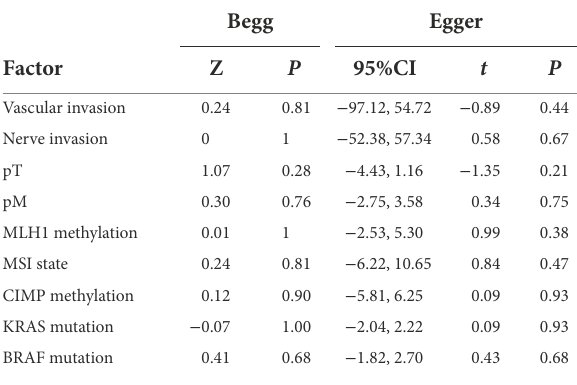
TABLE 4 Risk of bias for meta-analysis. Begg